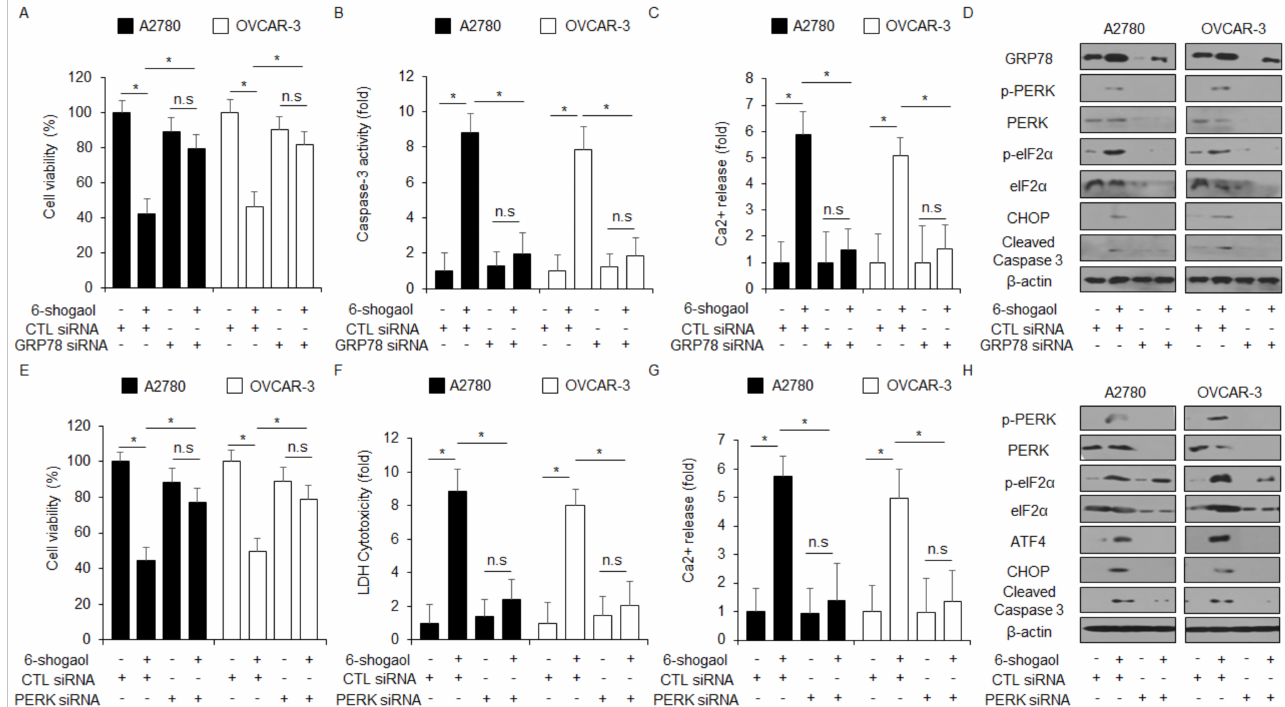
Figure 4. Inhibition of ER stress sensors suppressed by 6-shogaol caused cell death in ovarian cancer cells. ( A – C ) A2780 and OVCAR-3 cells were transfected with GRP78-specific siRNA in the presence or absence of 6-shogaol (30 µ M, 24 h) and WST-1, caspase-3 activity, and intracellular Ca 2+ assay were performed; *, p <0.05. ( D ) Western blot analysis of GRP78, p-PERK, PERK, p-eIF2 α , eIF2 α , ATF4, CHOP, and cleaved caspase-3 in 6-shogaol (30 µ M, 24 h)-treated A2780 and OVCAR-3 cells was performed in the presence or absence of GRP78 siRNA (30 nM, 24 h). β -actin was used as protein loading controls. ( E – H ) After A2780 and OVCAR-3 cells were transfected with PERK (30 nM, 24 h), WST-1, LDH cytotoxicity assay, intracellular Ca 2+ assay, and Western blotting analyses were performed with/without 6-shogaol (30 µ M, 24 h) treatment.; *, p < 0.05. n.s = not significant. Western blotting was carried out to identify the ER stress-related genes p-PERK, PERK, p-eIF2 α , eIF2 α , ATF4, CHOP, and caspase-3 cleavage in 6-shogaol-treated PERK knockdown cells. β -actin was used as a protein loading